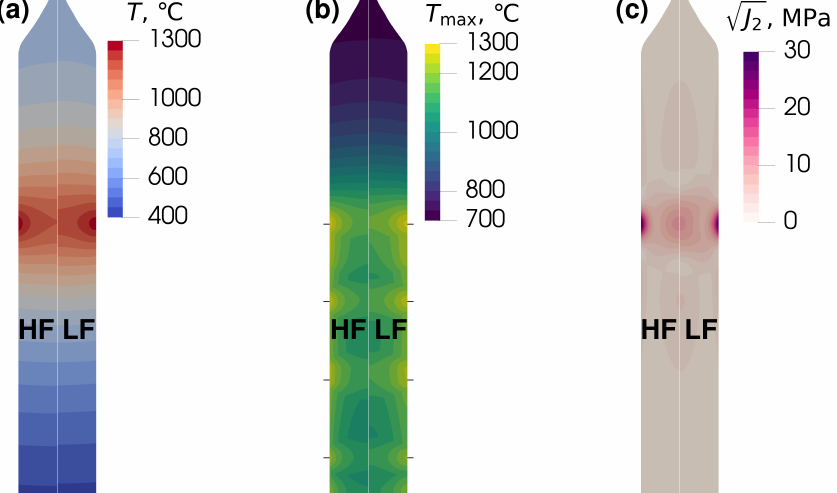
Figure 6. Simulation results at the end of heating ( t = 215min); zoom-in at the upper part of the crystal. ( a ) temperature, ( b ) maximum temperature during the whole simulation, ( c ) elastic thermal stress. Left side: HF mode; right side: LF mode. Black horizontal lines in ( b ) show heating positions at which the crystal is not